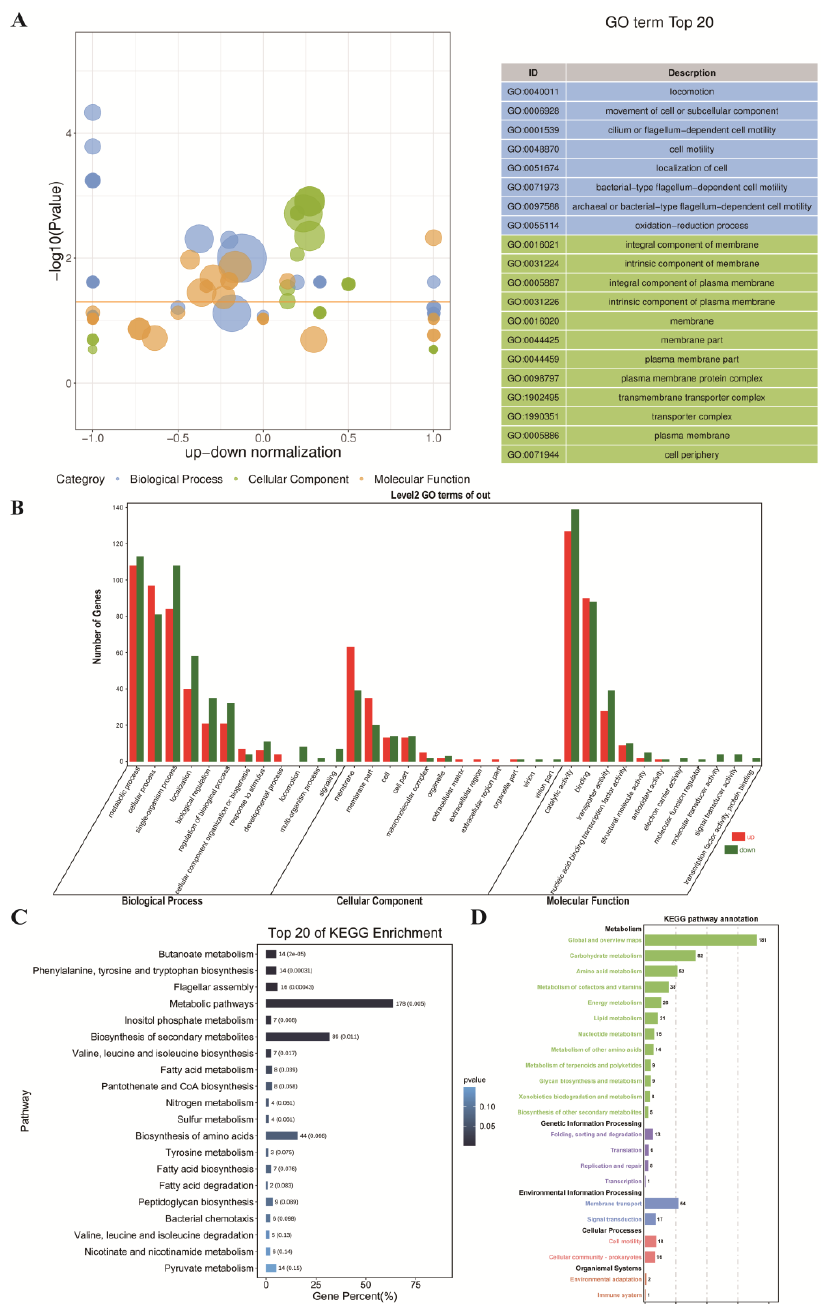
Figure 5. GO enrichment analysis ( A , B ) and KEGG enrichment analysis ( C , D ) of the ML co-treatment group and the LA treatment group. ( A ) Regarding the z-score bubble chart of GO enrichment analysis, the ordinate is −log10 ( p value), and the abscissa is the up–down normalization value (the ratio of the difference between the number of differentially up-regulated genes and the number of differentially down-regulated genes to the total differential genes). The size of the bubble represents the number of target genes enriched by the current GO term; the yellow line represents the threshold of p -value = 0.05; the right side is the list of the top 20 terms with the p -value, and different colors represent different Ontologies. ( B ) Statistical plot of secondary classifications for GO enrichment analysis. The abscissa is the different GO terms, and the ordinate is the number of target genes enriched by the current GO term. Genes that are up-regulated are represented by red, while genes that are down-regulated are represented by green. ( C ) Bar graph of the top 20 significantly enriched pathways. ( D ) Statistical chart of the B-class classification for each